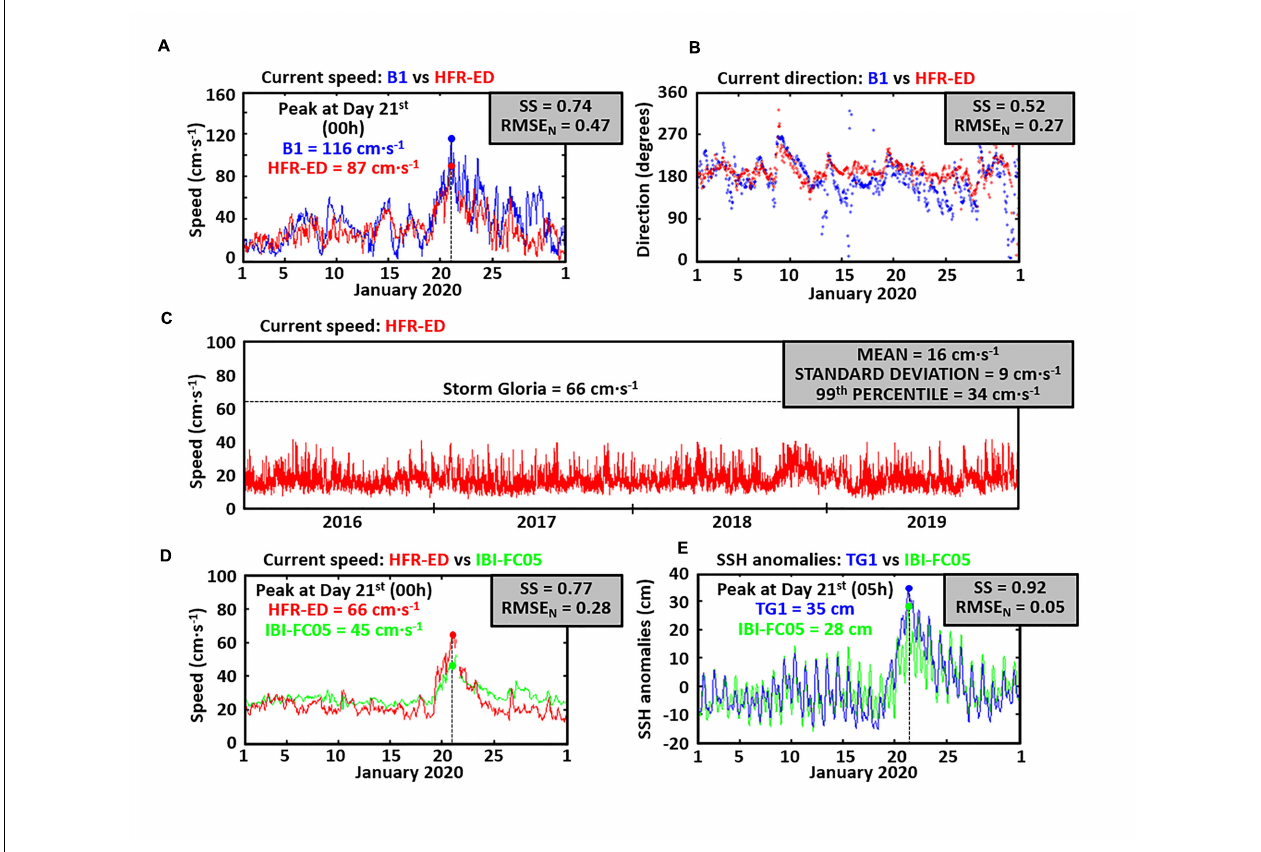
FIGURE 5 | Comparison of hourly surface current speed (A) and direction (B) provided by B1 buoy (red) and HFR-ED (blue) at the closest grid point, for January 2020; (C) 4-year timeseries of hourly surface current speed provided by HFR-ED, spatially averaged over the HFR coverage; (D) Comparison of hourly current speed provided by HFR-ED (blue) and IBI-FC05 model (green), spatially averaged over the HFR coverage, for January 2020; (E) Comparison of hourly anomalies of sea surface height (SSH) provided by TG1 tide-gauge (blue) and IBI-FC05 model (green) at the closest grid point, for January